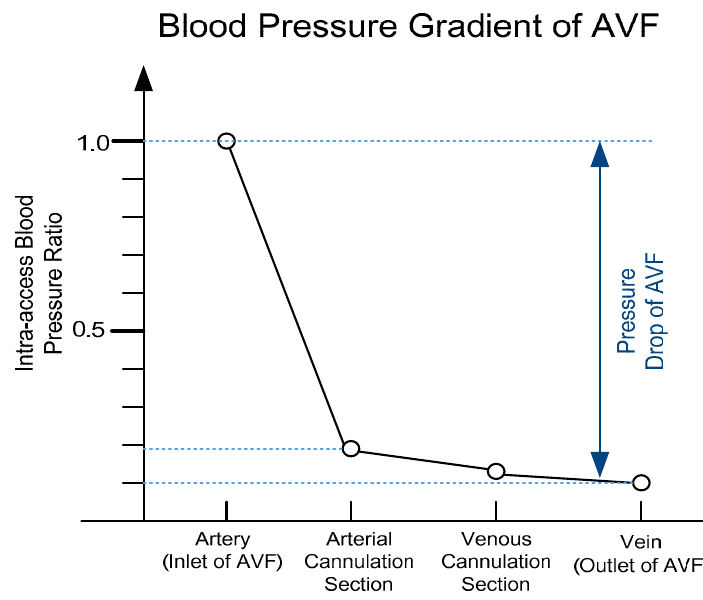
Figure 1. The blood pressure gradient of arteriovenous fistula (AVF), where it can be observed that there is a severe blood pressure drop (>90% decrease) across AVF (based on Reference [1]). Therefore, in Equation (5), the energy power dissipation of AVF can be approximated using only the blood pressure at the inlet of AVF as